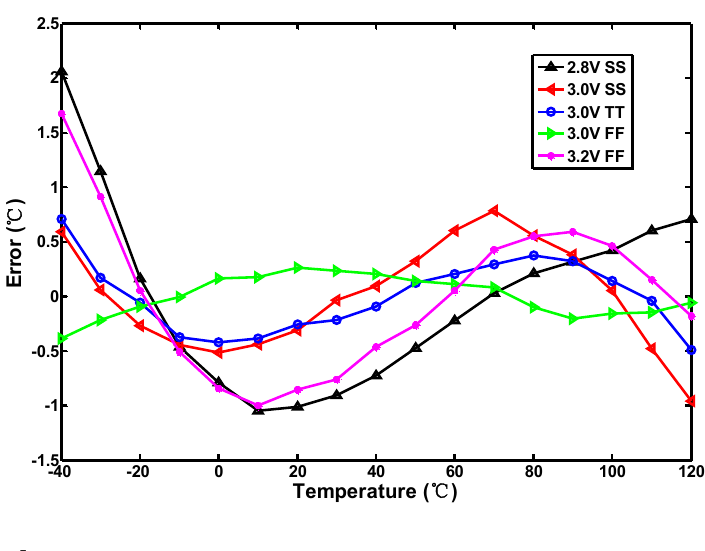
Figure 9. Simulated errors of proposed sensor for − 40–120 °